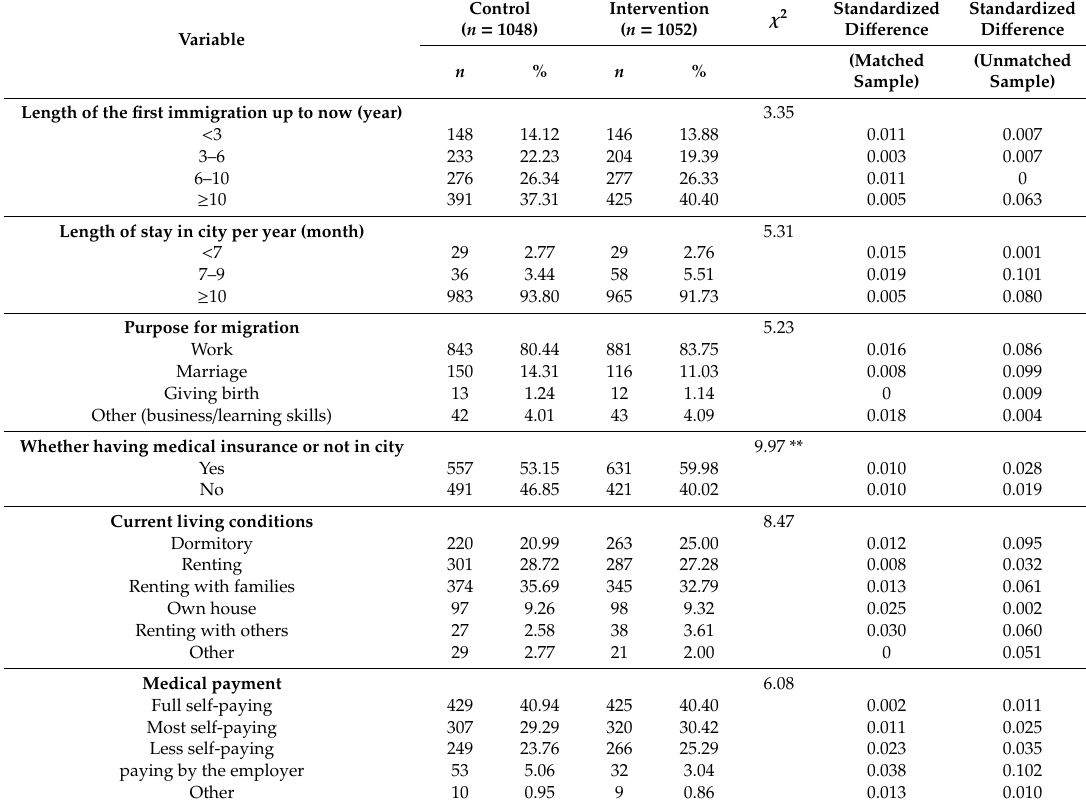
Table A4. Comparison of migration characteristics among participants between intervention and control groups in Beijing ( n =